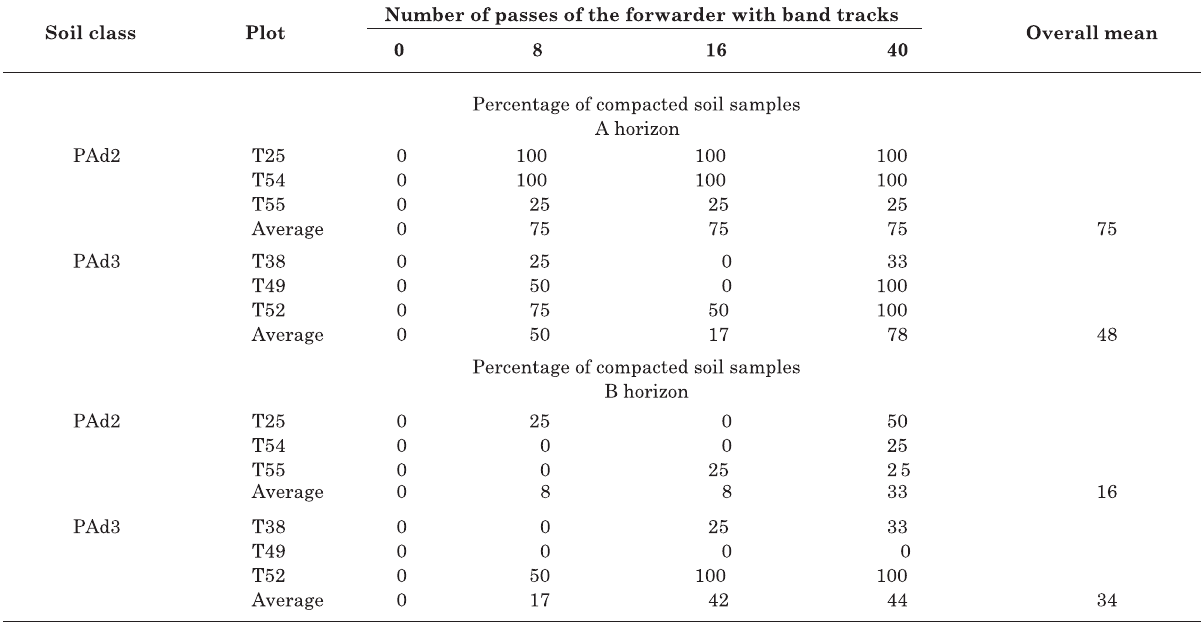
Table 7. Classification of the soil samples according to figure 1, using the preconsolidation pressures values determined before and after forwarder with crawler